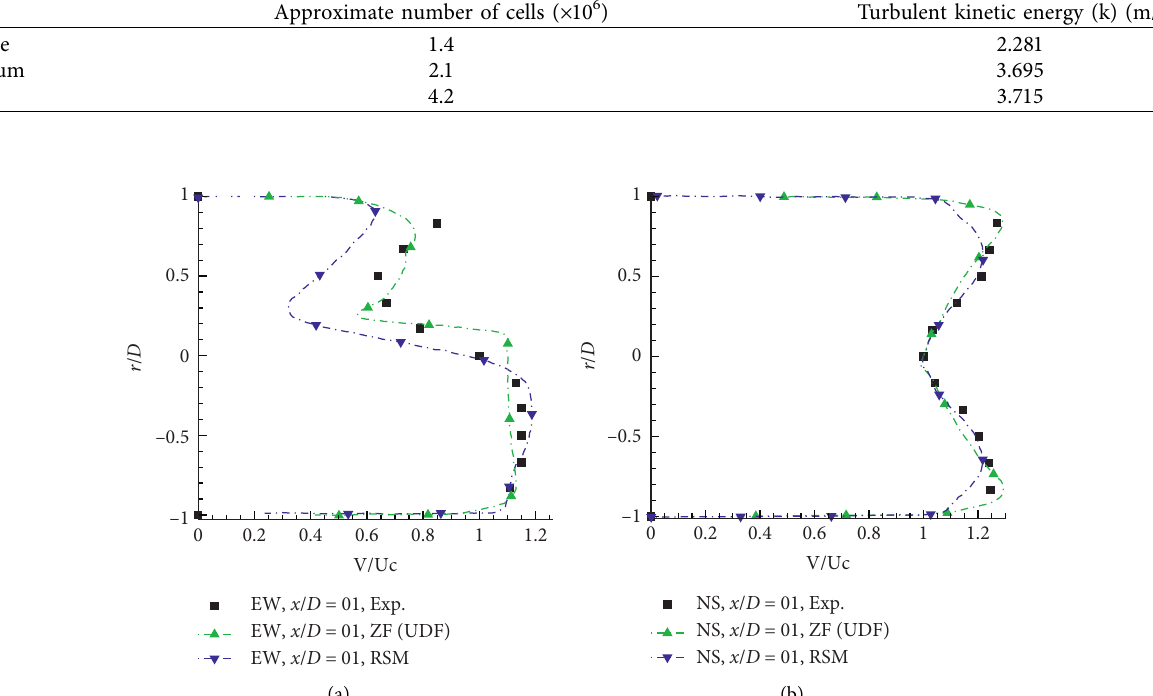
Figure 4: Normalized velocity profiles for different turbulence models at x / D � 1 for EW and NS directions.